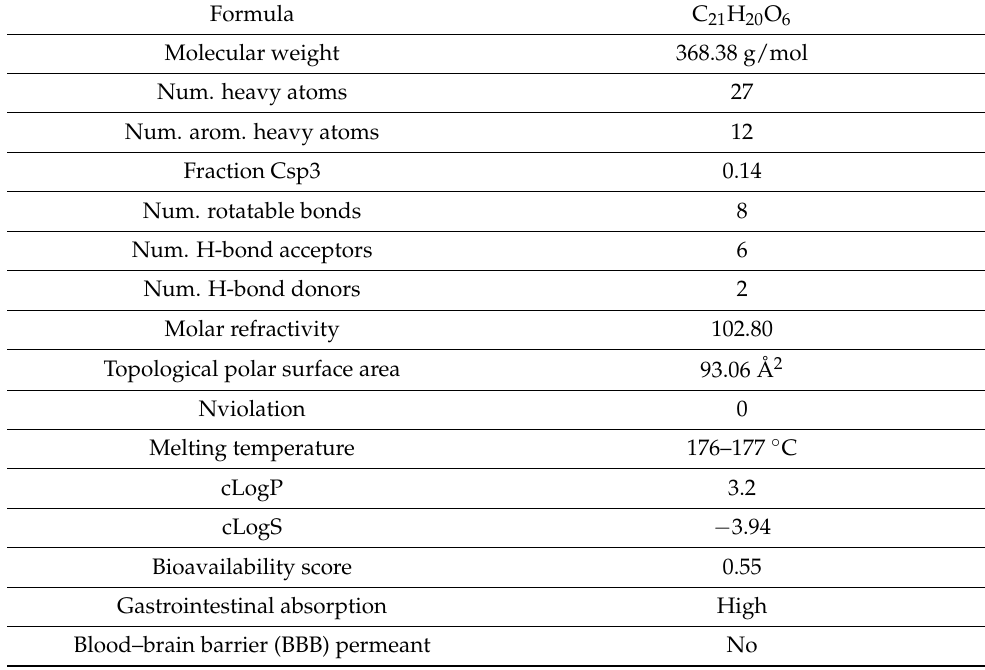
Table 1. Physicochemical properties of